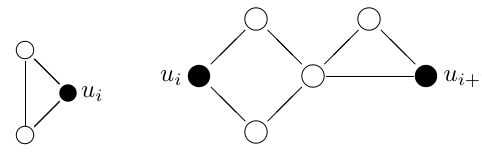
Fig. 2: Building bricks of the bad